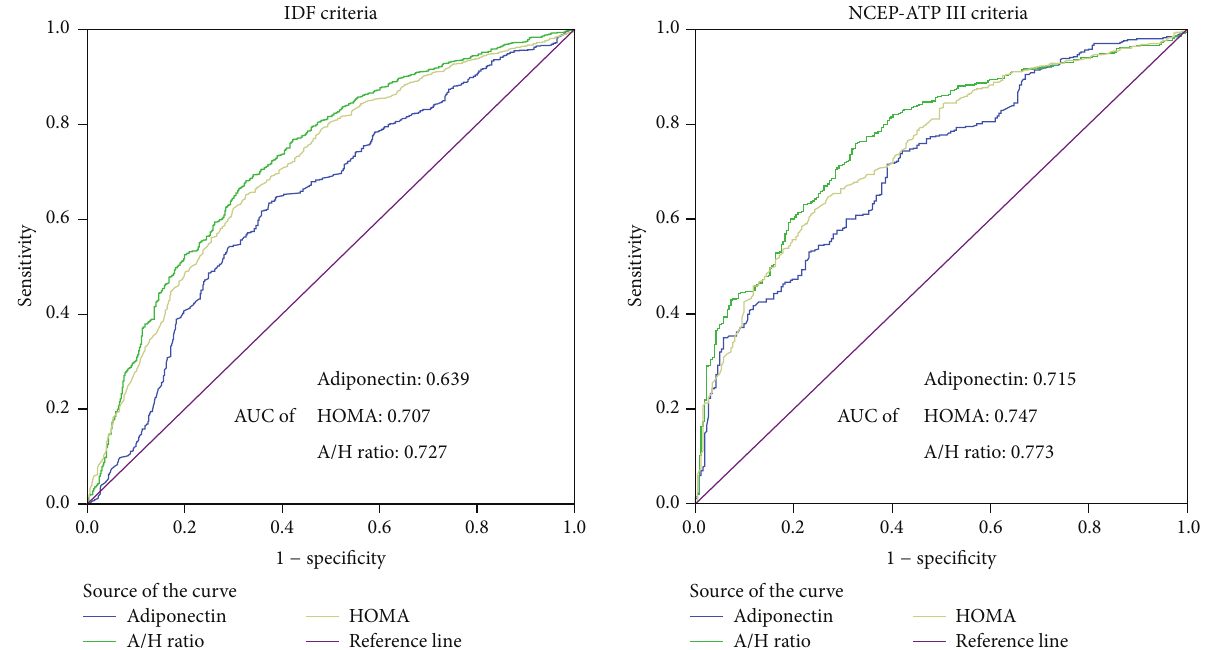
Figure 1: Comparison of predicting powers between adiponectin, HOMA-IR, and A/H ratio for difference metabolic syndrome criteria. HOMA-IR, homeostasis model assessment of insulin resistance; A/H ratio, adiponectin to homeostasis assessment-insulin resistance; ROC, receiver operating characteristic; AUC, area under the curve; IDF, International Diabetes Federation; NCEP-ATP III, National Cholesterol Education Program Adult Treatment Panel